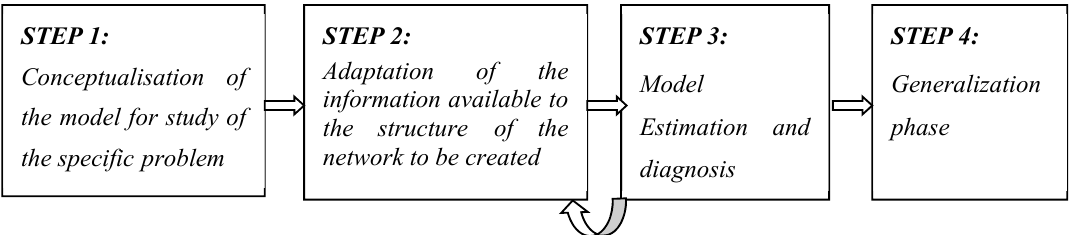
Figure 4. Steps in the empirical application of the model.